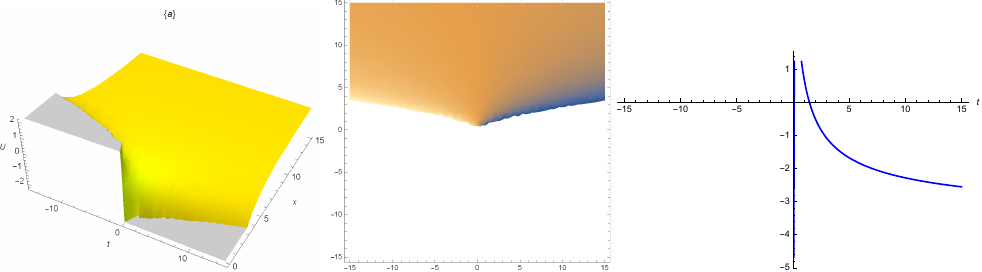
Figure 3. The 3D and 2D solution profiles of